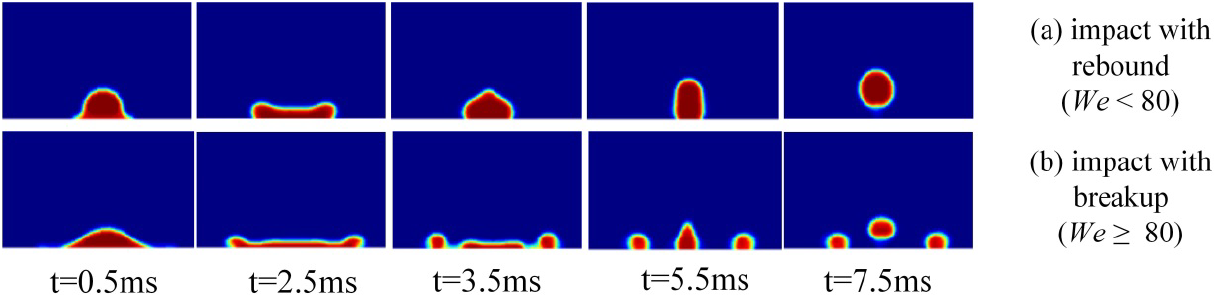
Figure 4. Spreading factor against time for different Weber numbers. (Comparison between the experimental data ( a ) and the numerical simulations ( b ).)